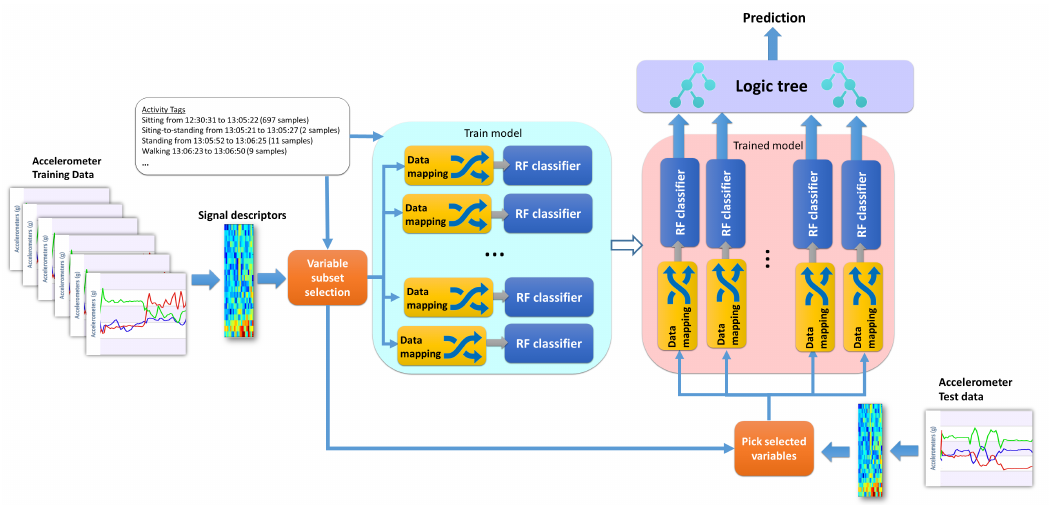
Figure 4. Training and testing architecture of the dichotomous mapped forest. The logic tree at the end of the testing phase is the same as depicted in Figure